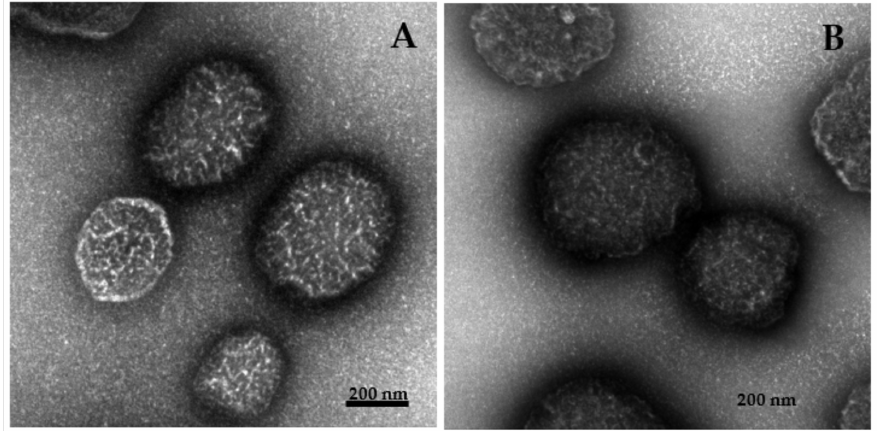
Figure 5. TEM images of bare PNCDHA nanogel ( A ) and cur-loaded PNCDHA nanogel ( B